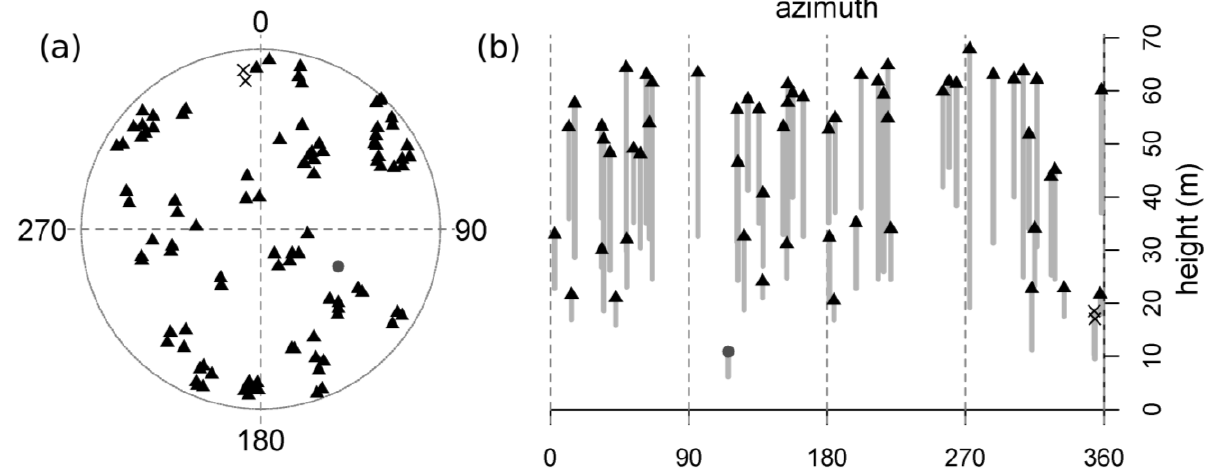
Figure 3. A representative no-tanoak plot (HCR-S5; see Table 1). Trees are mapped (a) and represented vertically (b; top height and height-to-live-crown are plotted against azimuth, thus “unrolling” the 360 degree view from plot center, and achieving a two-dimensional image by flattening all distances from plot center into a single plane). Symbols represent the following: “X”s = dead tanoak (reconstructed); gray circles = living tanoak; black triangles = redwood; no other species were present in this plot. Gray bars display the length of the live crown (the symbol at the top of each bar is the total tree height and the lower limit of each bar is the